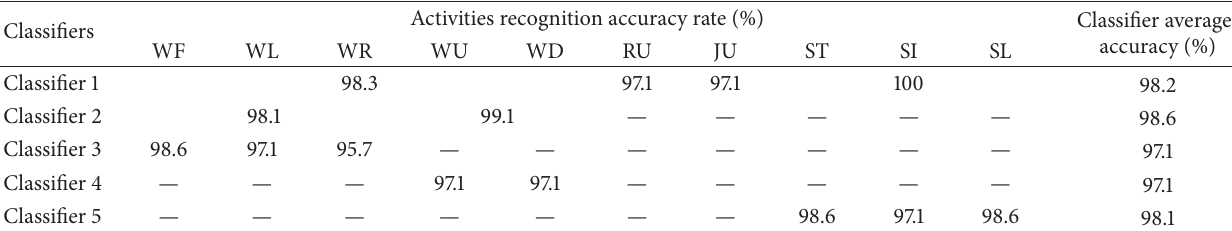
Table 3: Activity classifier accuracy test.